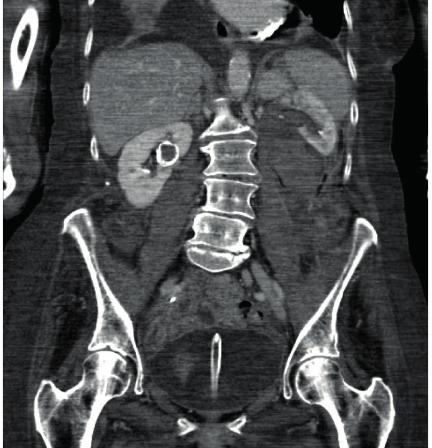
Figure 1: Split bolus contrast CT KUB: transverse section, left kidney.